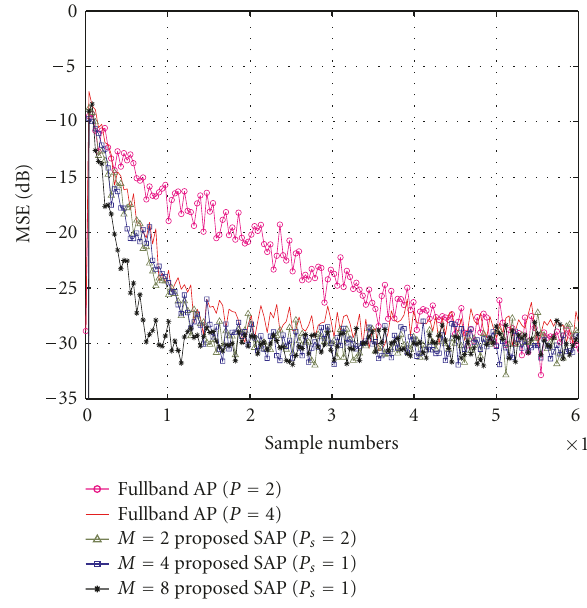
Figure 13: Comparison of MSE curves of the simplified SAP